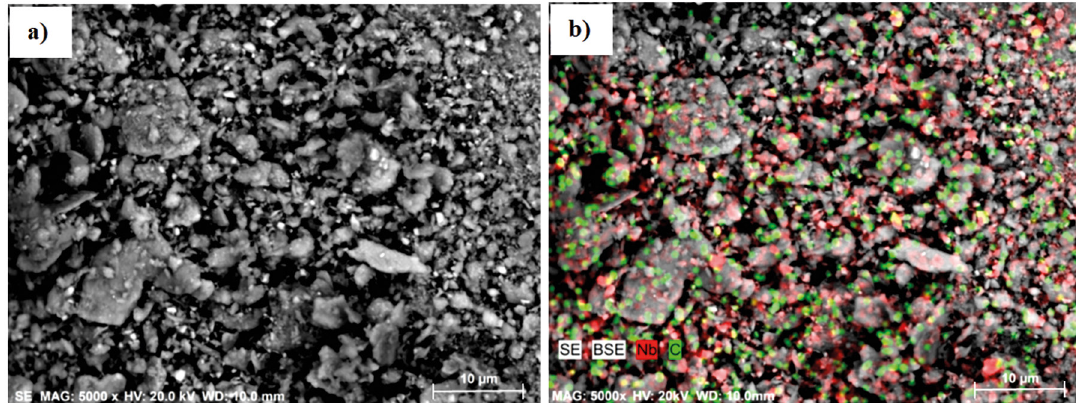
Figure 7. SEM image of aluminum bronze particles after 100 hours in the BSD mode (a); mapping analysis for NbC particulate identification (b).